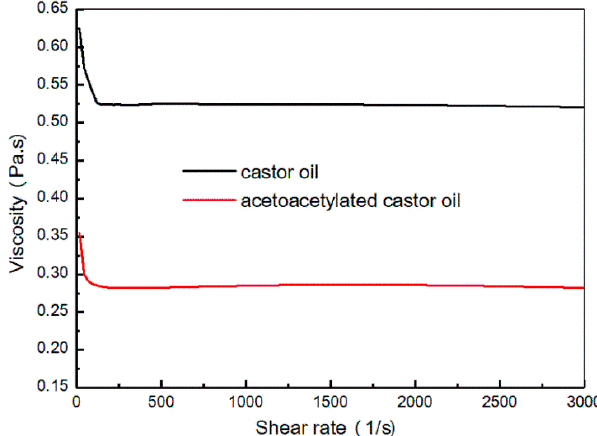
Figure 2. Rheological viscosity versus shear rate for castor oil and acetoacetylated castor oil.